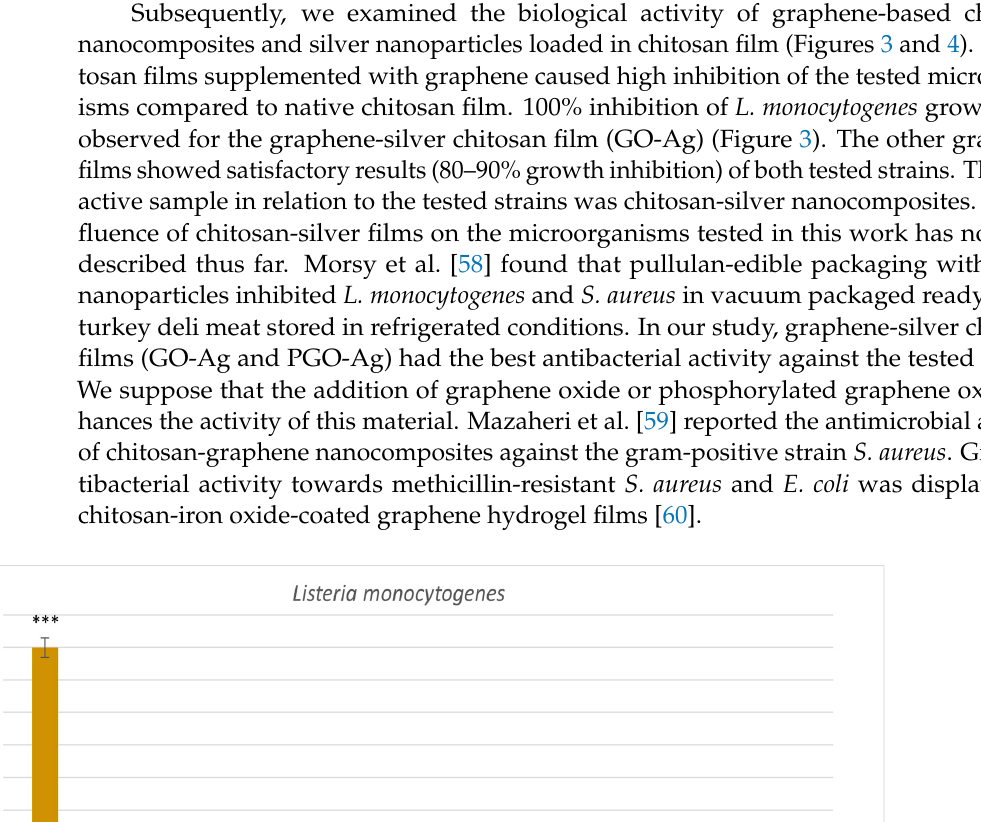
Figure 4. Reduction of Campylobacter jejuni ATCC 33560 with treatments with metal ‐ oxide chitosan films after 24 h incu ‐ bation. The value from control group (CS) was set as 100%. Statistical significance is marked in relation to the chitosan nanocomposite (CS) ( n = 6, * p < 0.05, *** p < 0.001). 2.1.1. Permeability of Bacterial Cell Membranes Tested samples with the best antibacterial activity towards L. monocytogenes and C. jejuni were stained using the LIVE/DEAD BacLight TM Bacterial Viability Kit according to the manufacturer’s protocol. Syto 9 penetrates cells with damaged and intact membranes, while PI penetrates only the cells with a damaged membrane and reduces the Syto 9 dye. Bacterial cells with intact membranes were stained green (Figure 5A,D,E,H), while dead or injured cells were stained red (Figure 5B–D,F–H). However, it was difficult to obtain legible pictures of chitosan film samples by fluorescence confocal microscopy. In this case, scanning electron microscopy (SEM) proved to be a suitable technique.